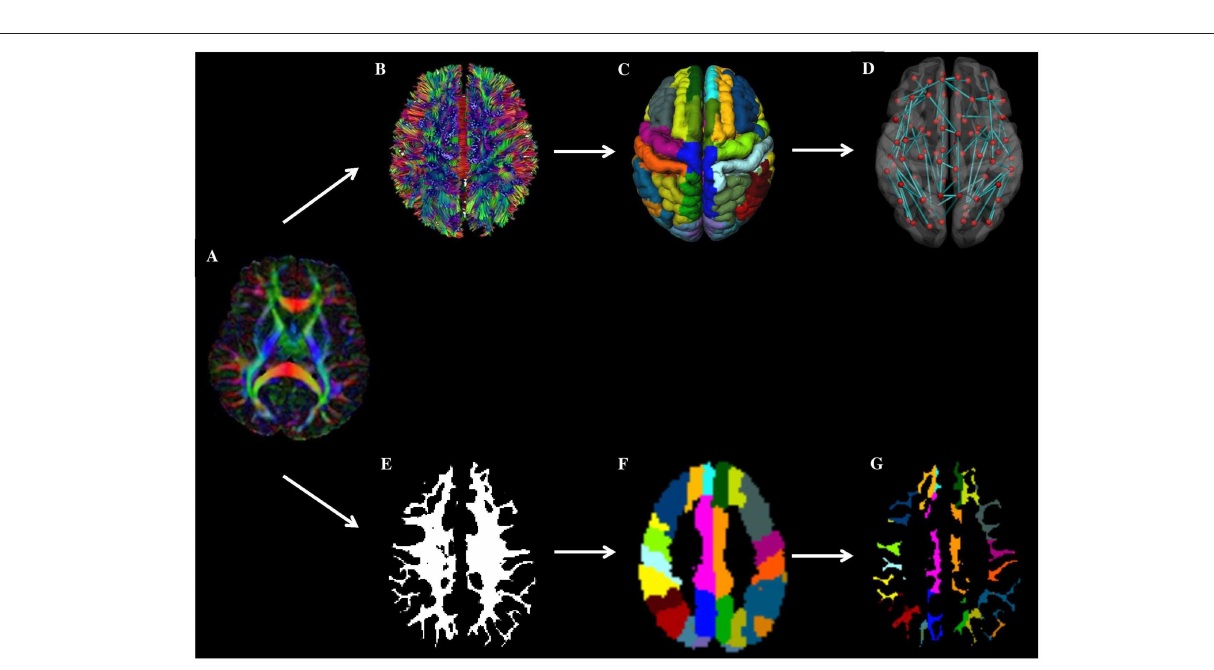
FIGURE 2 | Overview of workflow. In the top panel (network-based approach): from a patients’ DTI images (A), WM connections are reconstructed using fiber tractography (B). Next, brain network nodes were defined using the cortical parcellation using the AAL template (C). Subsequently, the structural brain network was reconstructed (D). Weighting of the network was done by multiplying each connection by the mean fractional anisotropy (FA) or mean diffusivity (MD). Finally, the mean FA and MD of connections towards high and low cortical microinfarcts (CMI) burden regions were compared between patients with and without CMIs. In the bottom panel (voxel-based approach), the patient’s DTI image A) is combined with the patient’s WM segmentation results (E) and AAL template (F) to assess diffusion properties of the WM voxels in the AAL region (i.e. directly underneath the cortex)